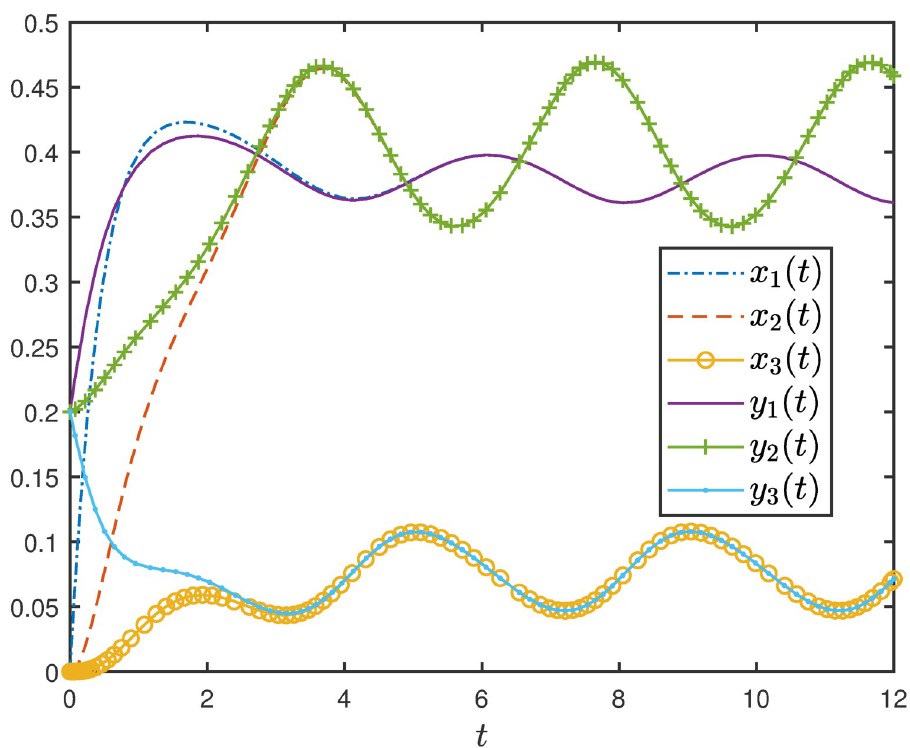
Fig 13. Trajectories of PEFEIOD in Example 10 as a function of time ( t ). Here, x i ( t ) and y i ( t ) are the trajectories of PEFEIOD corresponding to initial conditions [0, 0, 0] and [0.2, 0.2, 0.2] respectively.